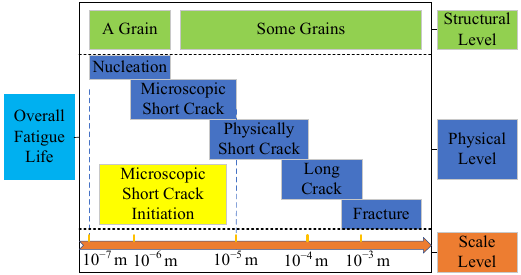
Figure 1. Fatigue lifetime stage diagram.